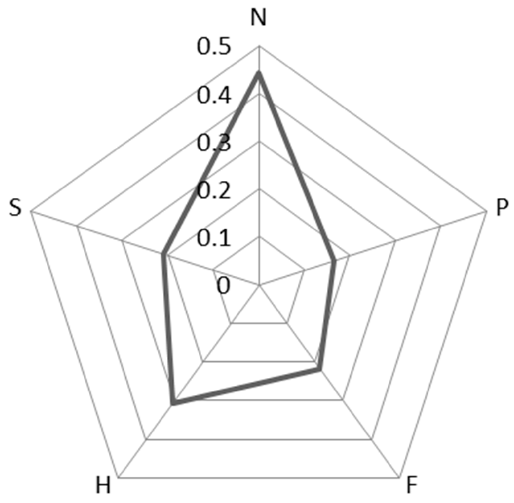
Figure 3. Pentagon of the herdsmen’s livelihood capital.